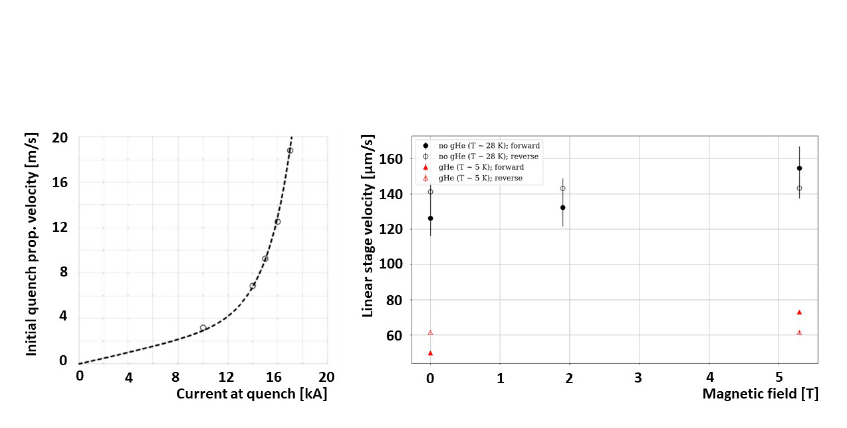
Figure 3. Left: Quench propagation velocity as function of applied voltage. Right: Speed of piezo motor carriage under di ff erent B-fields and helium gas